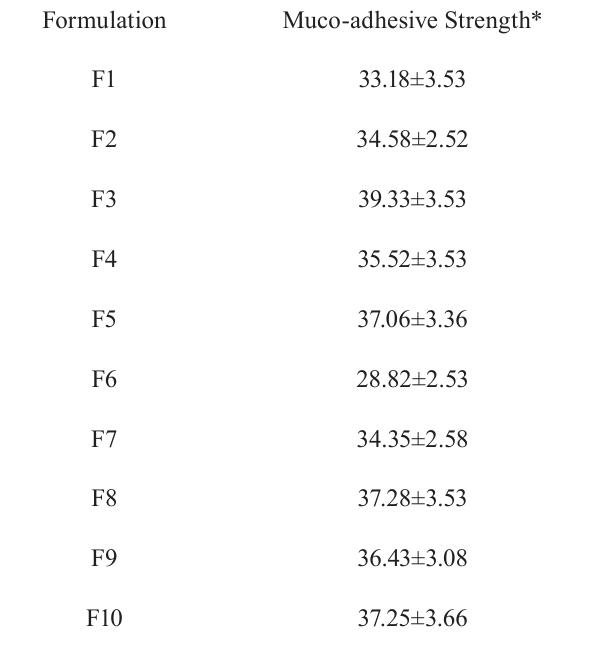
TABLE IV - Muco-adhesive properties of prepared buccal